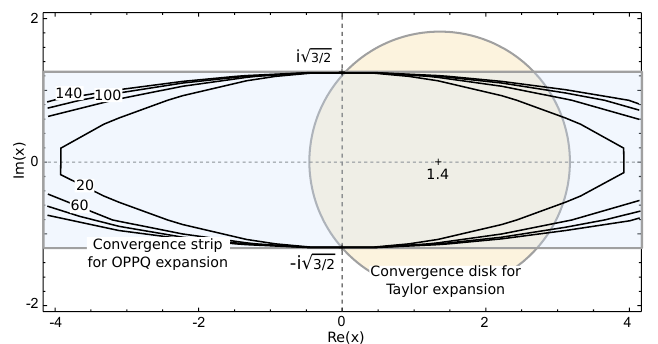
Figure 4. Converge domains in the complex plane for Taylor’s expansion and OPPQ / R ) of expansion for the ground state wave function scaled by the reference function ( Ψ gr the rational anharmonic oscillator in Equation (26). The OPPQ expansion is carried out for the sequence of truncation orders N = 20 , 60 , 100 and 140, showing that in the N → ∞ limit, its convergence domain is a horizontal strip bordered by the singular point of the wave function. In contrast, Taylor’s expansion does not converge outside the disk centered at the = 1 . 4 chosen expansion center, in the calculated case x 0